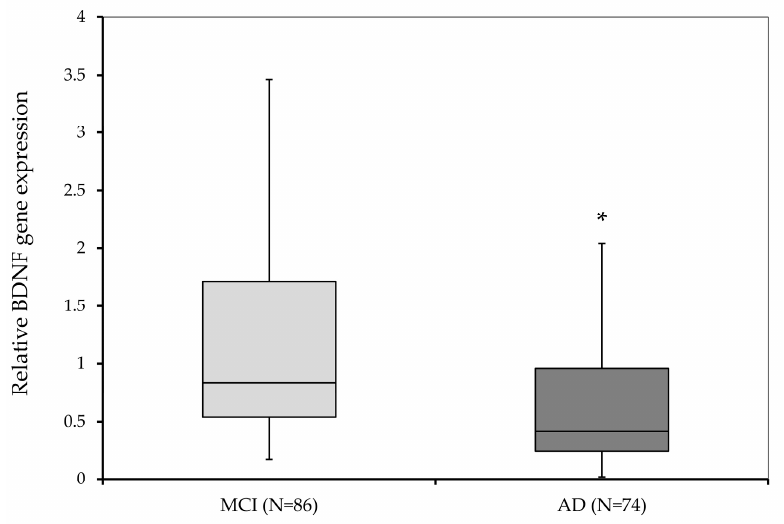
Figure 1. Relative BDNF gene expression in subjects with MCI and subjects diagnosed with AD. * p < 0.001.